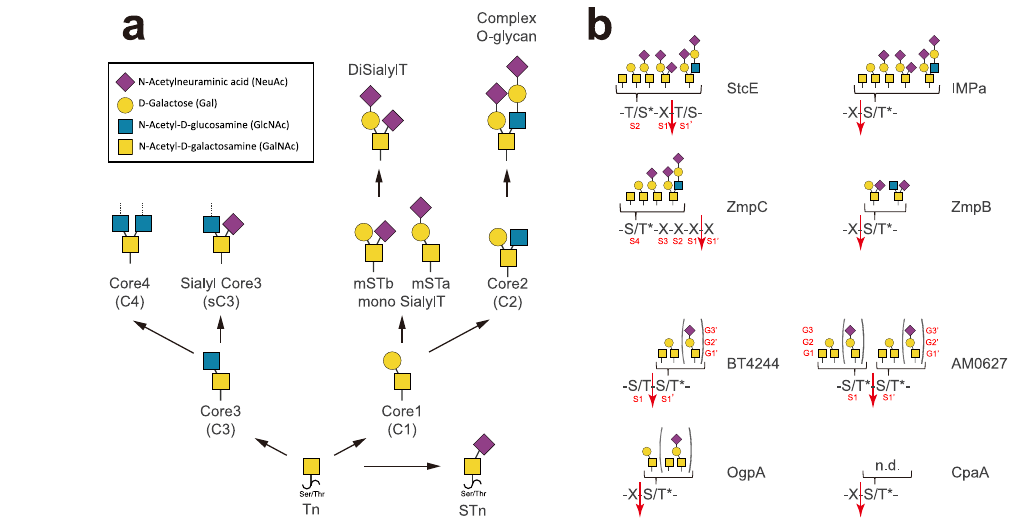
nomenclature for the amino acids and the sugar moieties of the glycoprotein substrates are indicated for StcE, BT4244, AM0627, and ZmpC as representative examples of these enzymes, and the red arrow indicates the cleaved point. Par- entheses indicate less favored O -glycan structures and n.d. indicates that the gly- can speci fi city is not